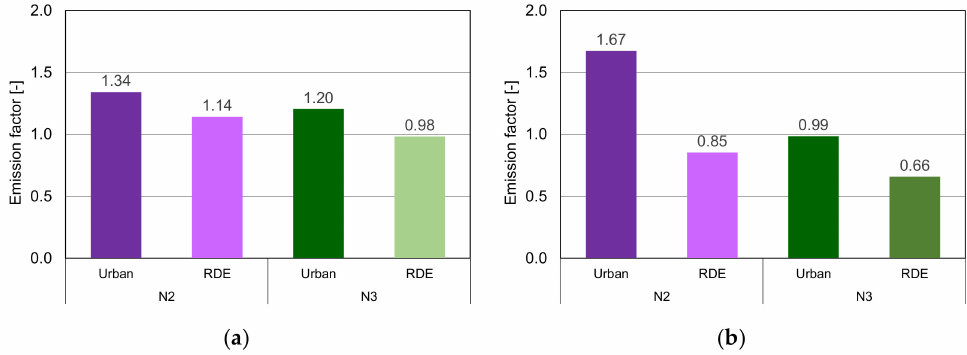
Figure 19. Emission factors (EF) for heavy-duty vehicles in environmental ( a ) and health ( b )